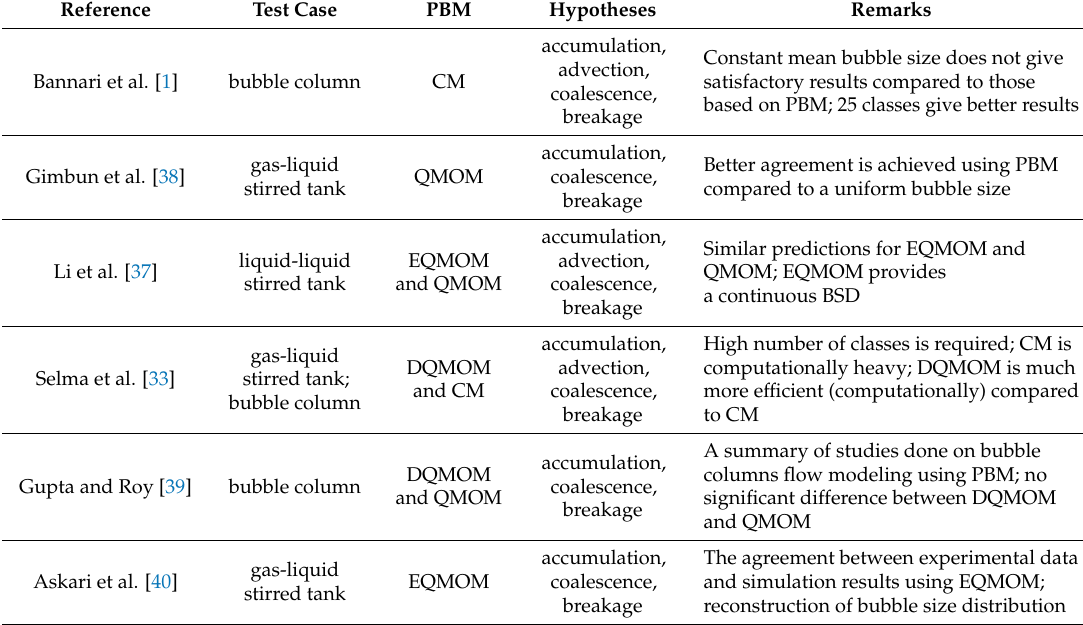
Table 1. The most remarkable studies in the field of bubbly flow modeling using Population Balance Model (PBM). CM, Method of Classes; EQMOM, Extended Quadrature Method of Moments; DQMOM, Direct Quadrature Method of Moments.